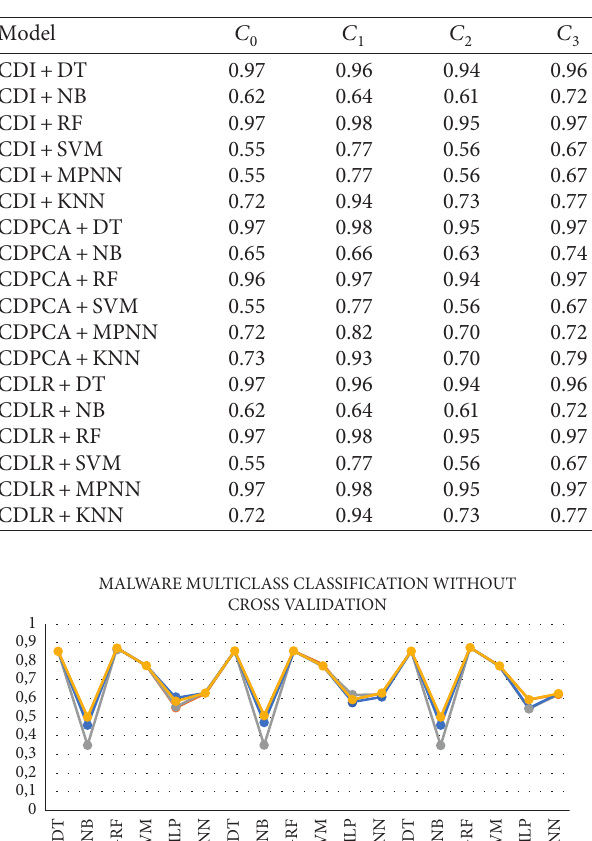
Table 10: The ROC curve final mixture of the performance results with multiclass without cross validation.